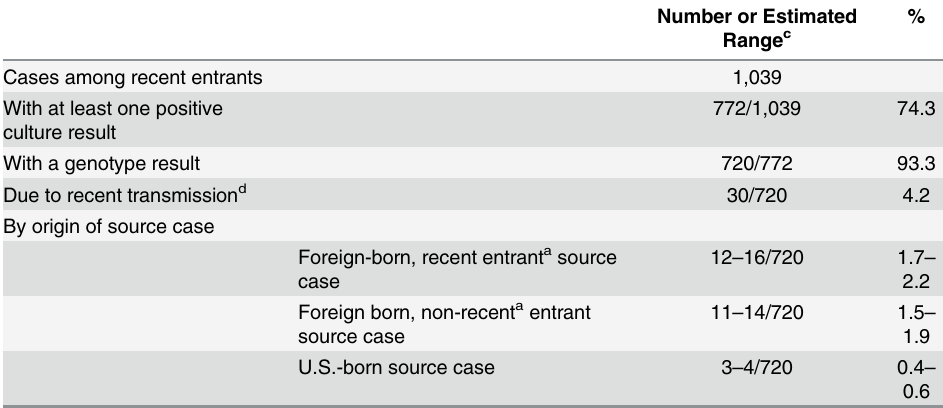
Table 5. Transmission of Mycobacterium tuberculosis among recent a entrants, 2011 b